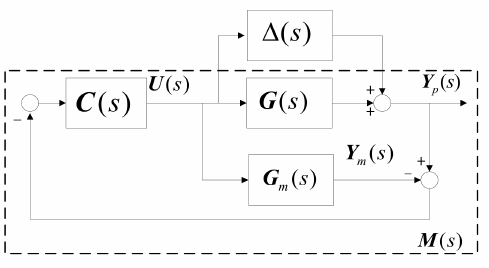
Figure 2. System with additive uncertainty and its M − ∆